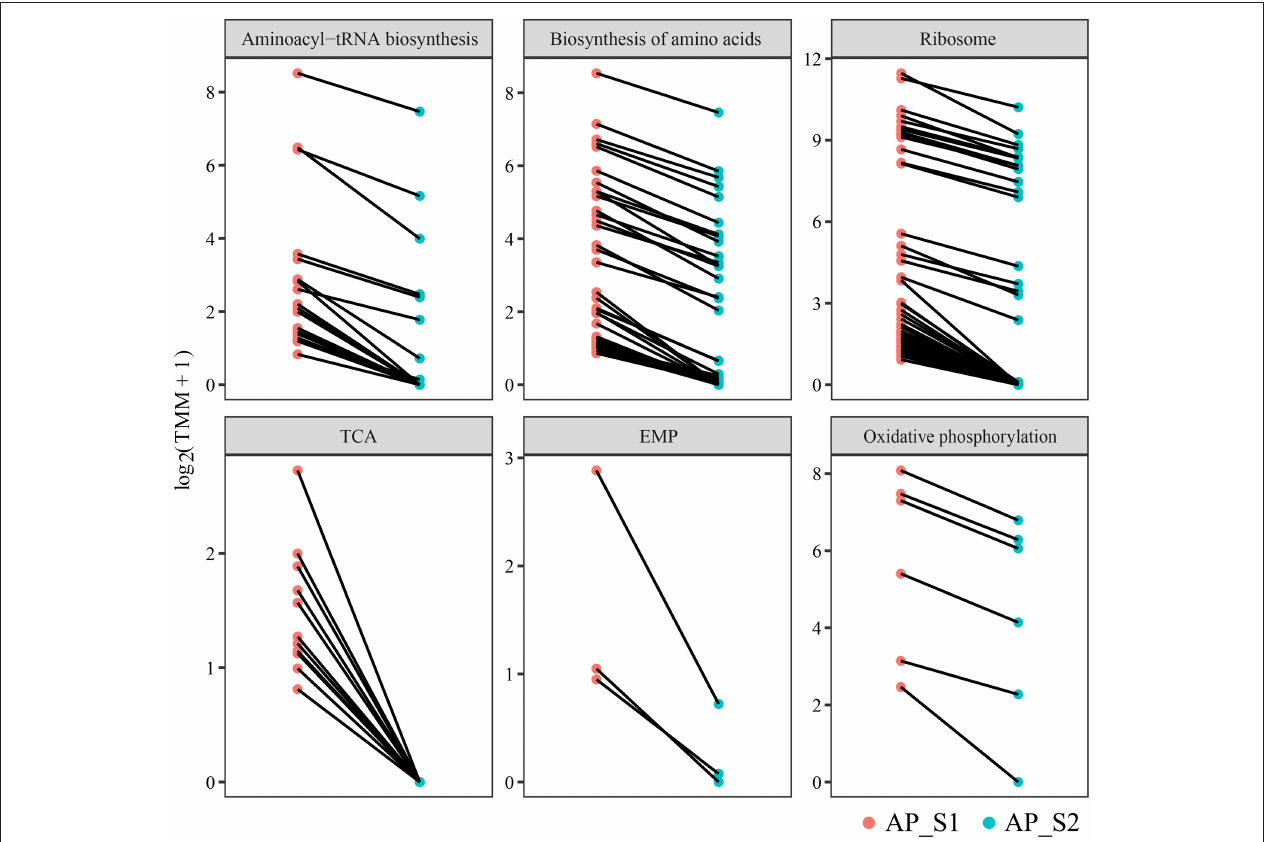
FIGURE 6 | Differentially expressed level of the DEGs involved in the amino acid synthesis and energy metabolism pathways among the two different harvesting periods of A. polytricha